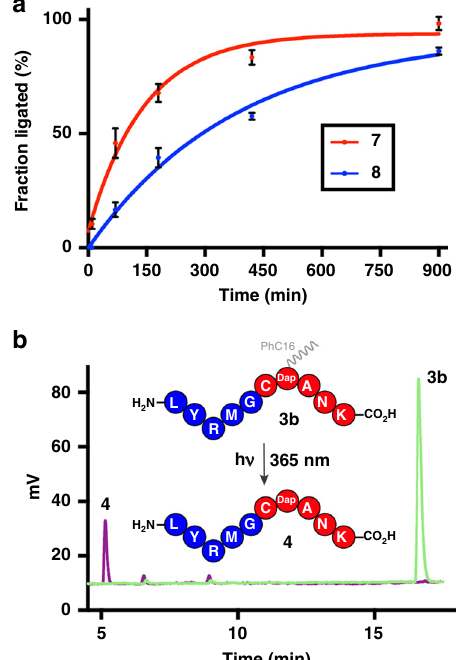
Fig. 3 Various ligations (Asn-Cys, Leu-Cys) and photocleavage reaction. a Kinetic measurements of NCL between the peptide thioesters LYRMN- α COSC8 ( 5a ) (1 mM) or LYRML- α COSC8 ( 6a ) (1 mM) and the peptide CDap(PhC16)ANK ( 2b ) (1 mM). Decapeptide ( 7 and 8 , respectively) formation was monitored over time using combined HPLC-ELSD-MS measurements. Error bars represent standard deviations (SD) ( n = 3). b Photocleavage reaction of the auxiliary on NCL product LYRMGCDap (PhC16)ANK ( 3b ) to generate the decapeptide LYRMGCDapANK ( 4 ). The photocleavage reaction was monitored using HPLC-ELSD-MS (raw ELSD data